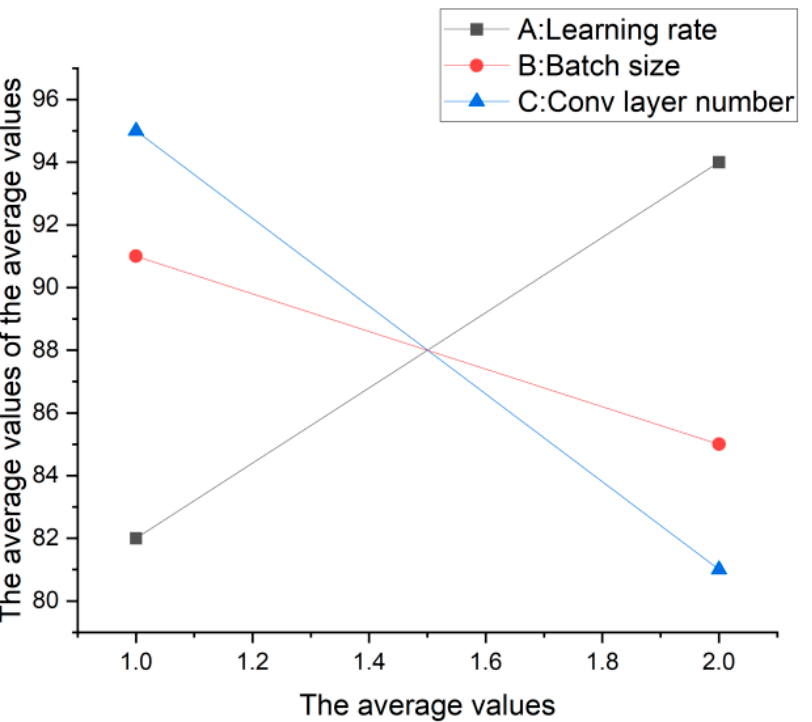
Figure 7. The main effect plot of average values.